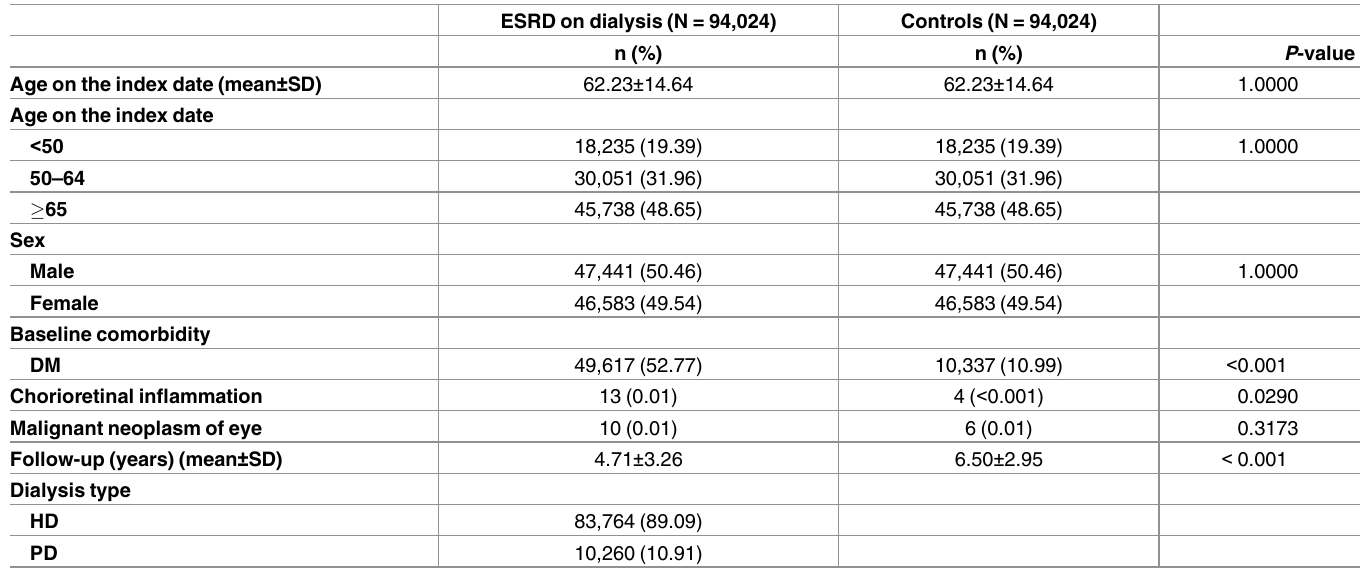
Table 1. Demographic characteristics and comorbid disorder comparisons between the ESRD on dialysis and control